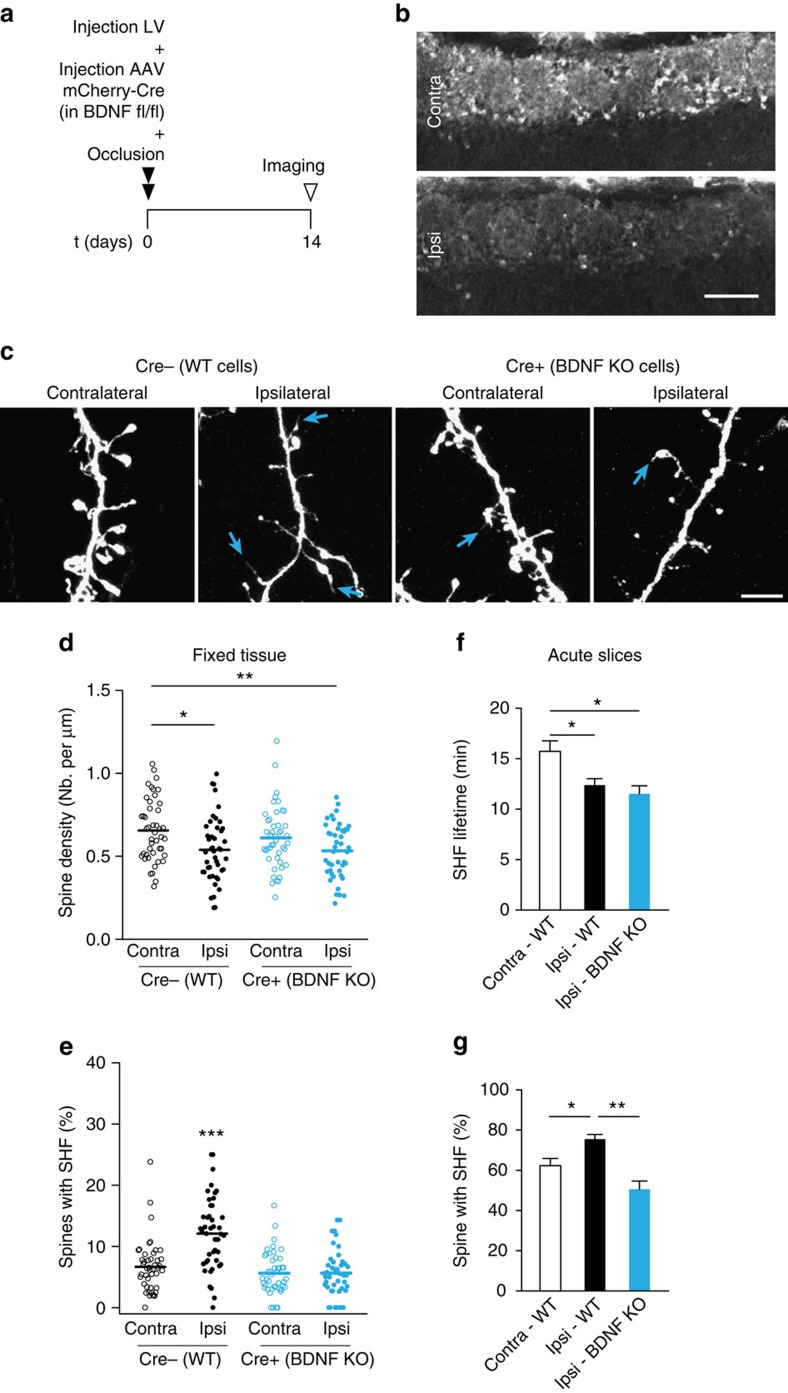
Spines with SHF are selectively maintained after sensory deprivation.(a) Experimental design of occlusion and simultaneous injections of GFP and Cre-mCherry viruses. The mice were killed 14 days after the surgery. (b) Tyrosine hydroxylase (TH) expression in the glomeruli layer demonstrating the efficiency of unilateral nostril occlusion. Scale bar, 100 μm. (c) Representative images of the distal dendrites of adult-born GC in the contralateral and ipsilateral bulbs in injected and uninjected regions of BDNF fl/fl mice. Scale bar, 5 μm. (d) Quantification of spine density on adult-born GC in different regions of the OB following sensory deprivation and BDNF knockout. (e) Quantification of the percentage of spines with SHF in fixed tissues (n=45 cells from 3 mice in each condition; *P<0.05, **P<0.01, ***P<0.001—one-way ANOVA with Tukey post hoc test for d,e). (f) Effect of sensory deprivation on the lifetime of SHF in the control and sensory-deprived bulbs of wild-type mice and in the sensory-deprived bulb of BDNF KO mice. The lifetime of the SHF was measured over a period of 60 min in time-lapse experiments using acute OB slices. (g) Percentage of spines with SHF. (f–g) n=12 and 9 cells from the contralateral and ipsilateral bulbs of 10 and 6 mice, respectively, and n=4 from 1 BDNF KO mouse. *P<0.05; **P<0.01 using the unpaired Student's t-test. ANOVA, analysis of variance